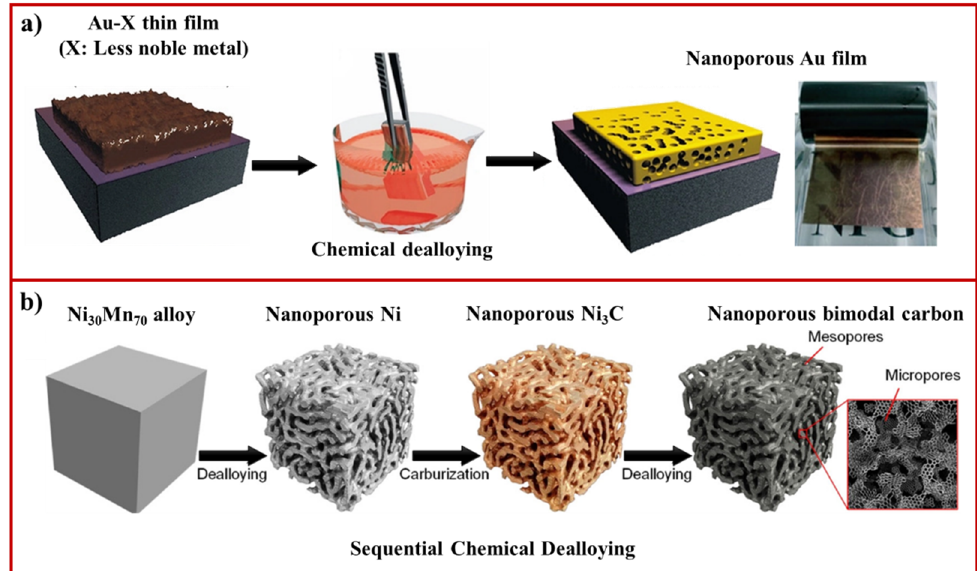
Figure 1. ( a ) Schematic illustration showing the fabrication of nanoporous Au thin film by selective chemical dealloying of Au-Ag film in acidic medium (adapted from [56], Copyright 2015, American Chemical Society); ( b ) schematic depicting the fabrication of 3D bimodal nanoporous amorphous carbon by sequential chemical dealloying (adapted from [57], Copyright 2021, American Chemical Society).